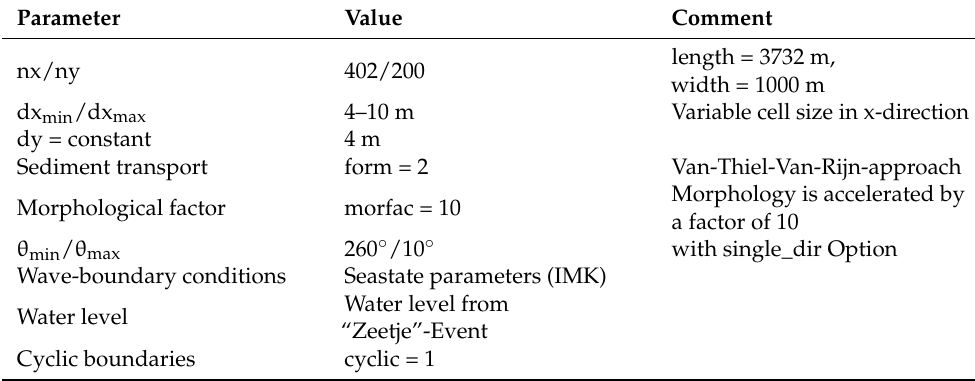
Table 4. XBeach model parameters and settings, Hütelmoor, “Zeetje” storm